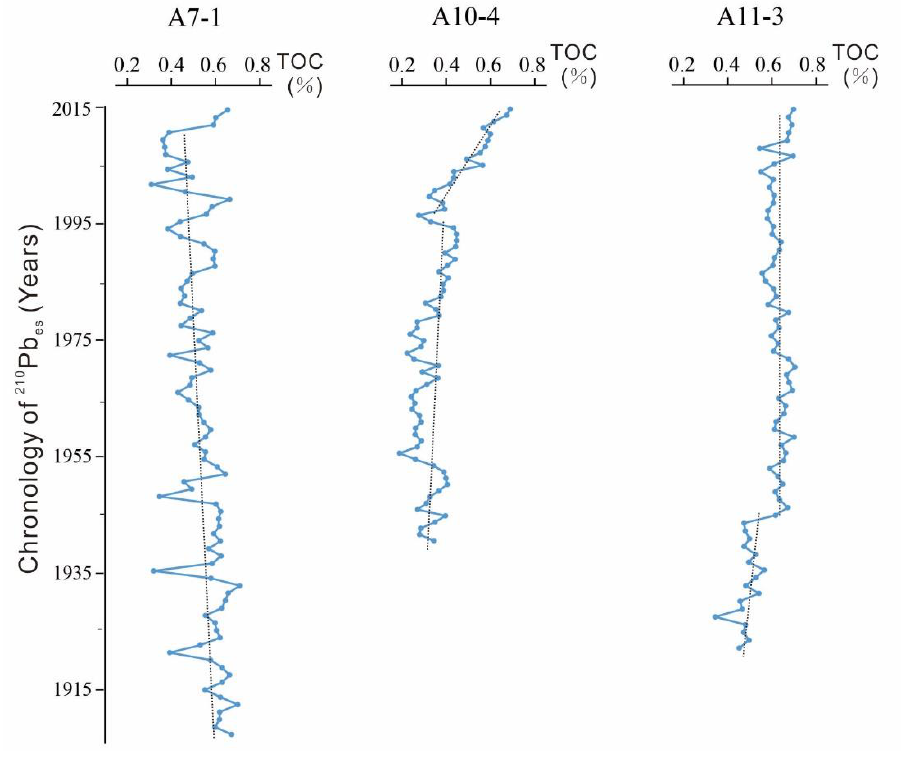
Figure 3. Results of TOC.